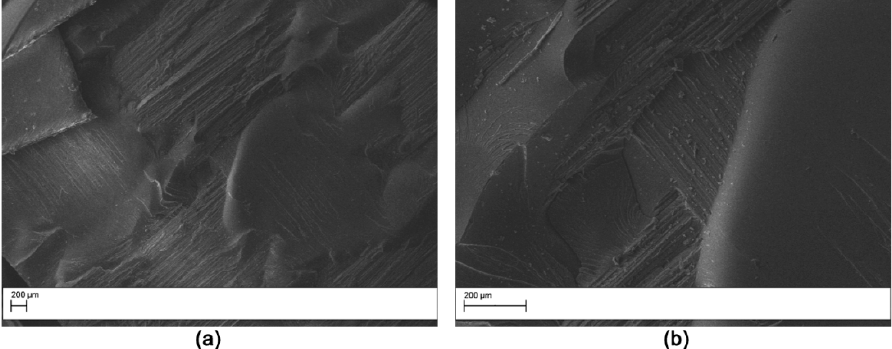
Figure 10. G IC values for the laminates modified with soluble veils.